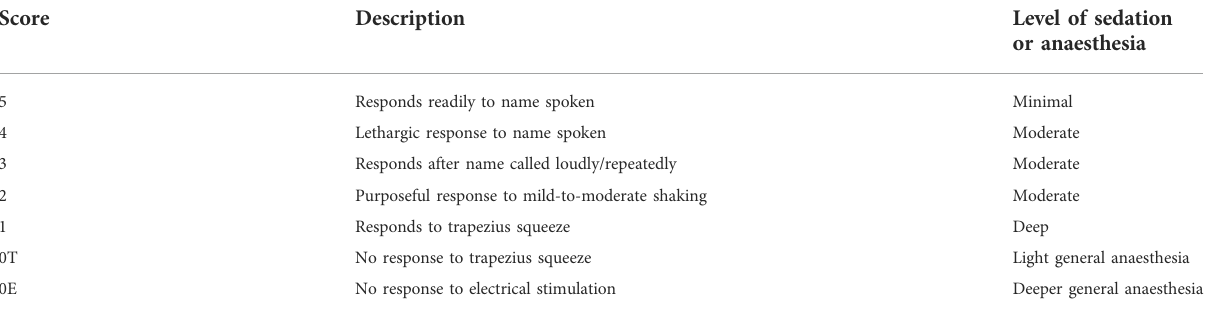
TABLE 1 Extended observer ’ s assessment of alertness and sedation (EOAA/S)